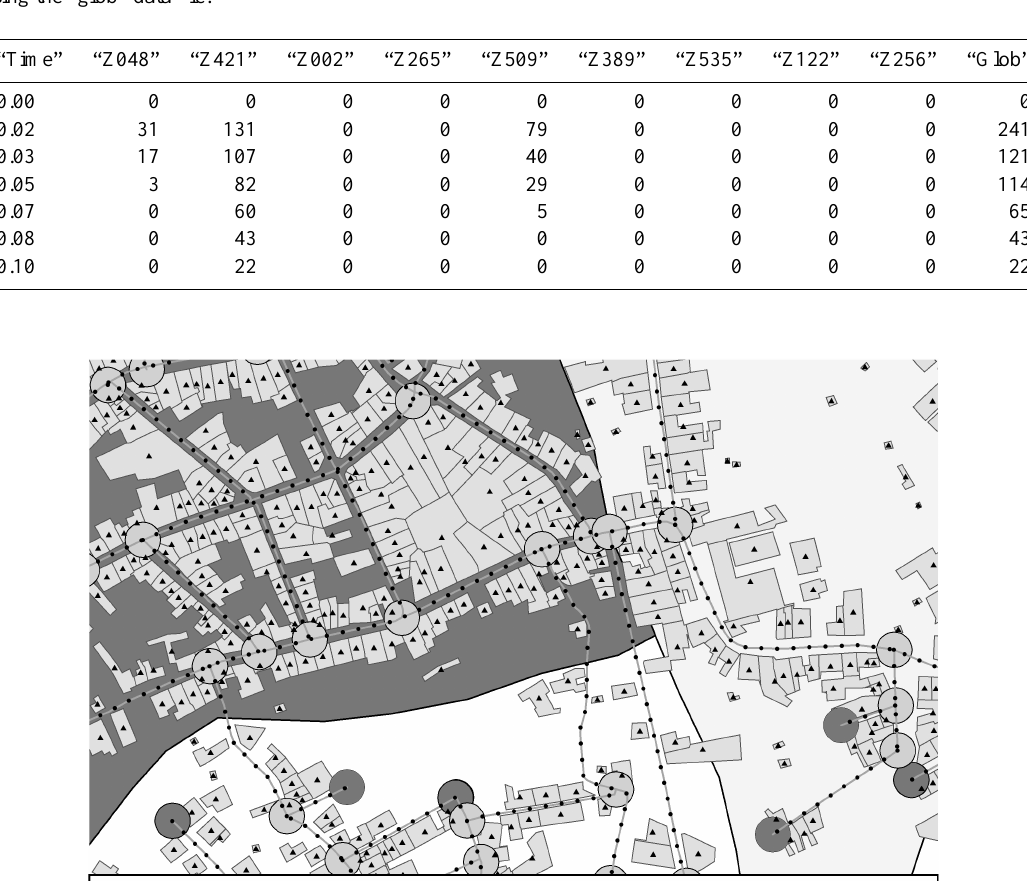
Table 2. Example of output file. For each zone, all data are updated every minute. An analysis can be done in one zone or throughout the work area using the “glob” data file.